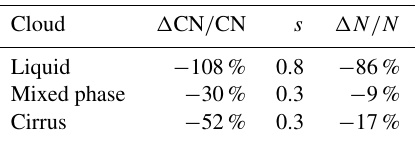
Table 9. Relative difference in cloud droplet and ice crystal num- ber N between MADE and M7 as predicted according to Eq. (2) from fitted susceptibilities s and domain-averaged values of relative differences in cloud nuclei (cid:49) CN / CN from the Passive simulation (Table